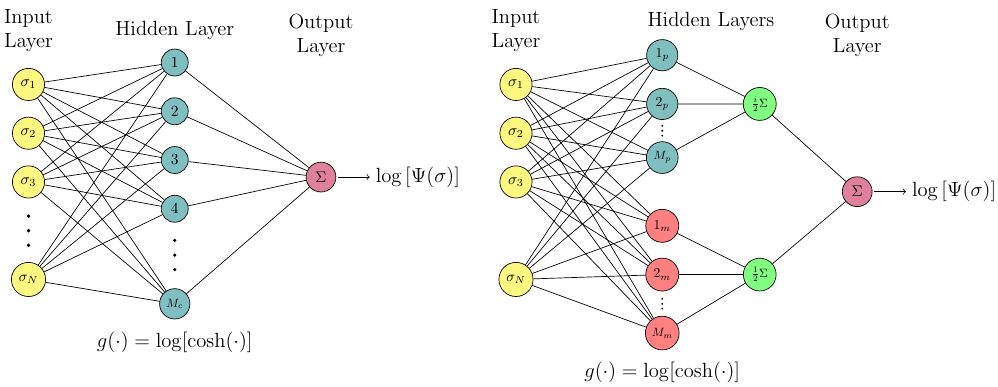
Figure 1: Schematic illustration of the feed-forward neural networks representa- tion of the cRBM state of Eq. (5) (left panel) and pmRBM state of Eq. (4) (right panel). The cRBM Ansatz has complex parameters and it is a fully-connected net- work; instead, the pmRBM state has real parameters and, due to its structure, is not fully connected. In both networks, the activation function of the hidden neurons is g ( · ) = log [ cosh ( · )] .